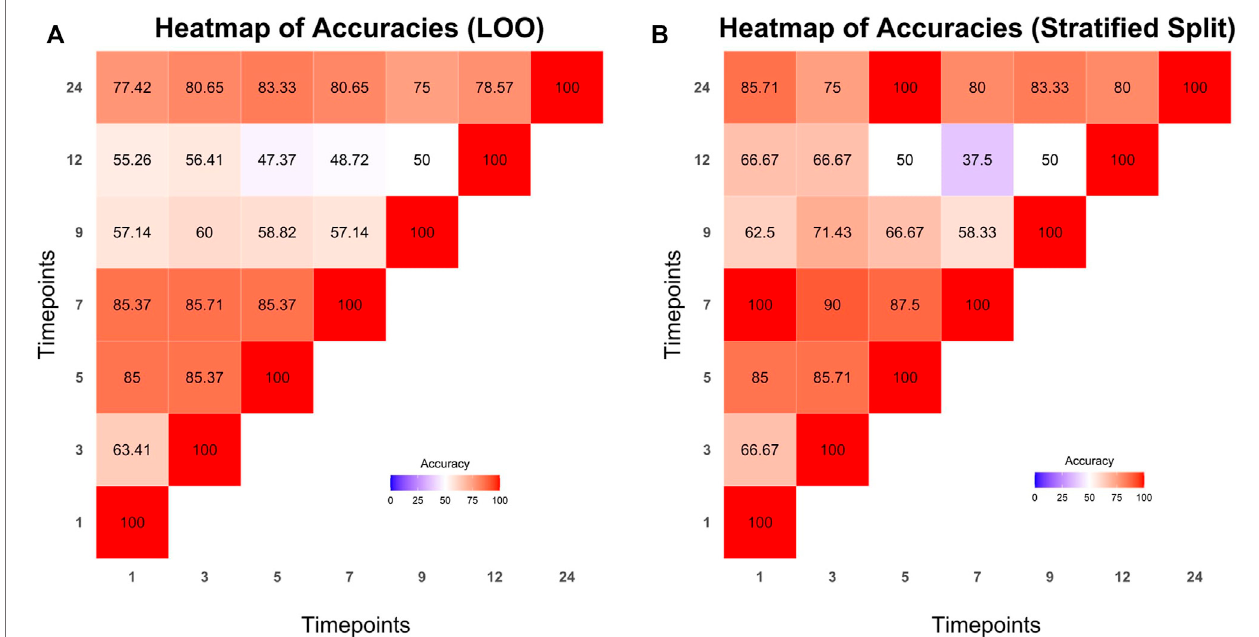
FIGURE 6 | Heatmaps presenting the prediction accuracies achieved from leave one out (A) and strati fi ed splits methods (B) respectively.Time points from which predictions are made are shown on the x axis while predicting time points are represented on the y